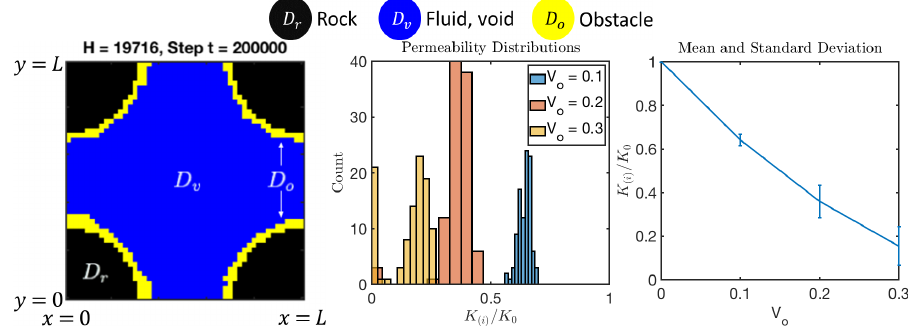
Figure 21. Results of LP model for biofilm-like obstructions in Section 6.1.1. Left: one of the ( i ) = 0.1. Middle and right show the experimental probability distribution of realizations D o for V o ( K ) ( i ) i for three values of V o